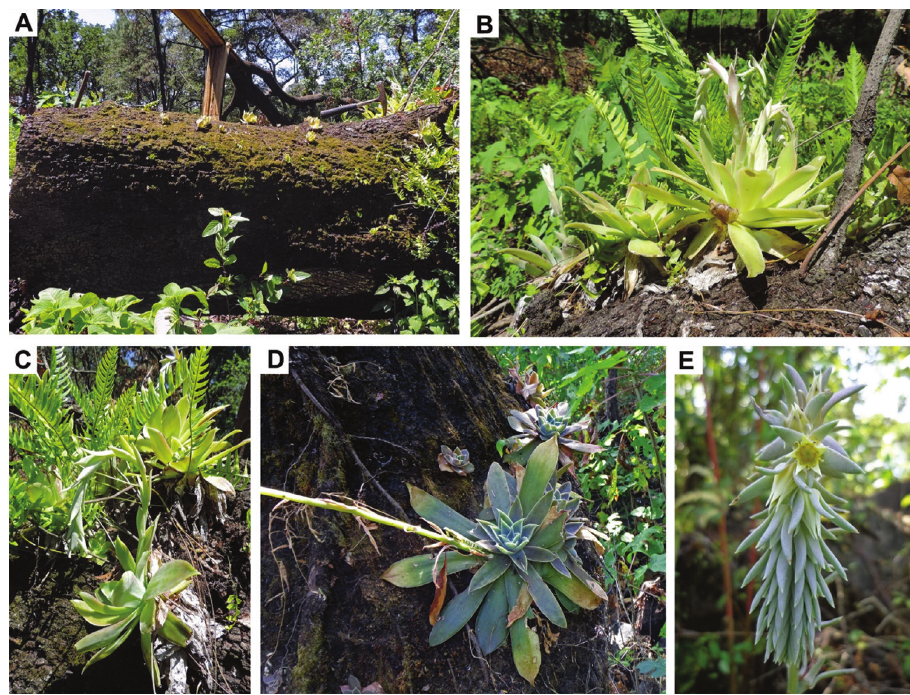
Figure 3. Echeveria yalmanantlensis in the new habitat from Michoacan. A General habitat view of young epiphytic plants B–D Leaf rosettes and developing plants E